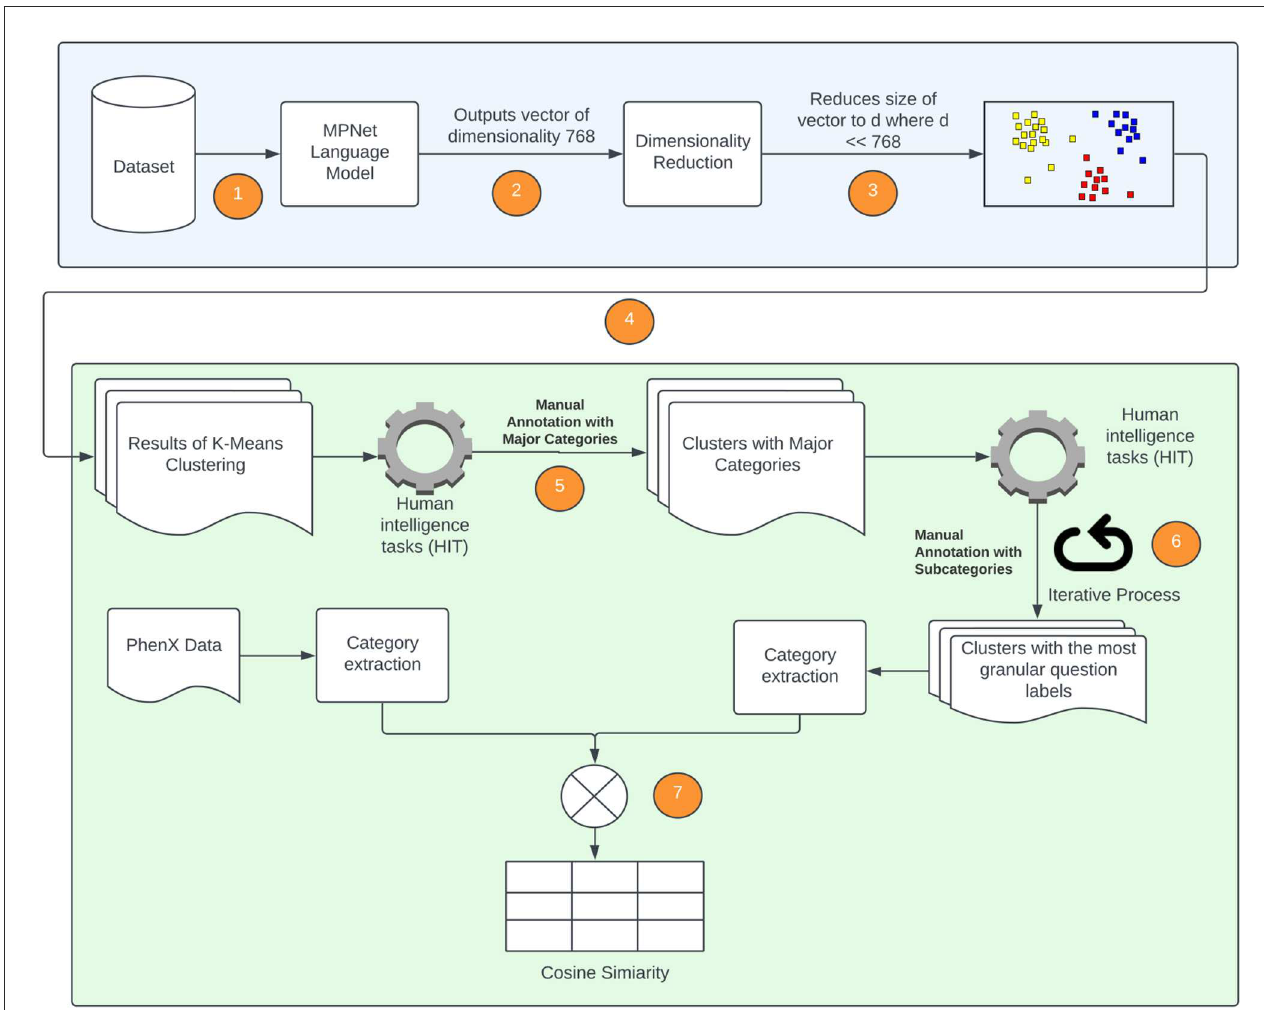
FIGURE5 Diagrammatic representation of processes followed to extract SDOH data from available forms. The numeric steps of the SDOH extraction pipeline are incorporated, and correspond to the following. 1. The language model is applied to the forms used to extract SDOH data; 2. The language model outputs a vector of dimension 768 × 1; 3. Locally Linear Embedding (LLE) is applied to reduce the dimension; 4. K-Means (spherical) is applied to data obtained in 3 to generate the clusters; 5. The clusters generated in step 4 are provided to SMEs to label them with an SDOH category; 6. The SMEs evaluate the clustering and re-categorize any misclassified questions; 7. The categories of the individual SDOH present in our data are compared with the SDOH categories present in the PhenX